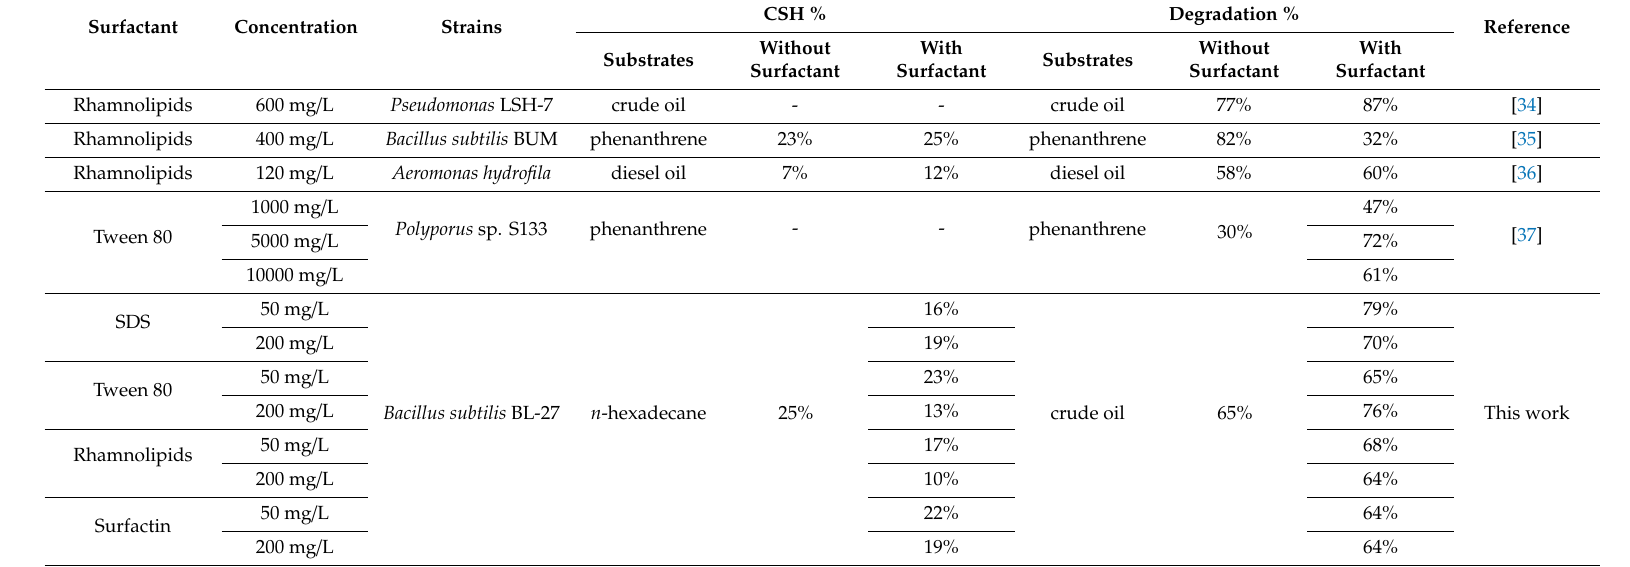
Table 4. The e ff ects of surfactants on CSH and biodegradation of